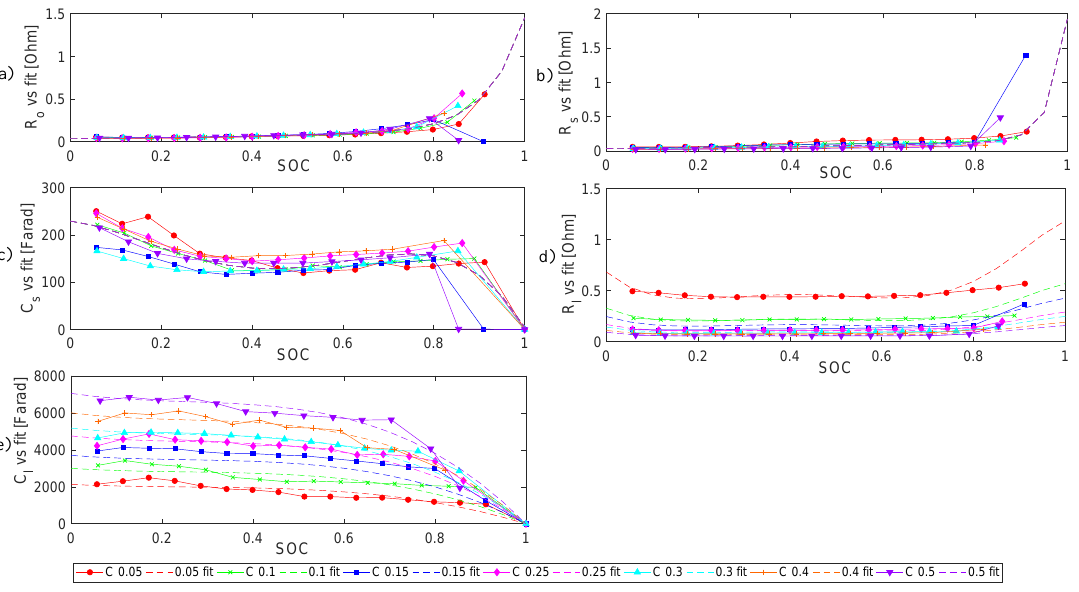
Figure 8. The values of RC elements and their fitted results: VRLA batteries during charge.